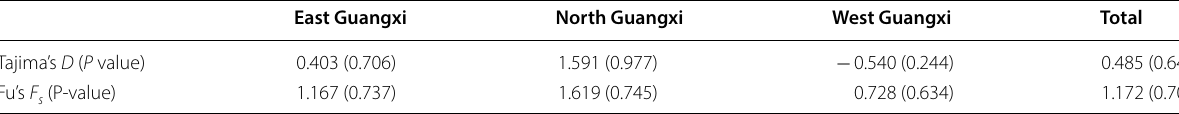
Table 4 Tajima’s D and Fu’s F statistics for Begonia luzhaiensis based on trnC - ycf6 spacer sequence s